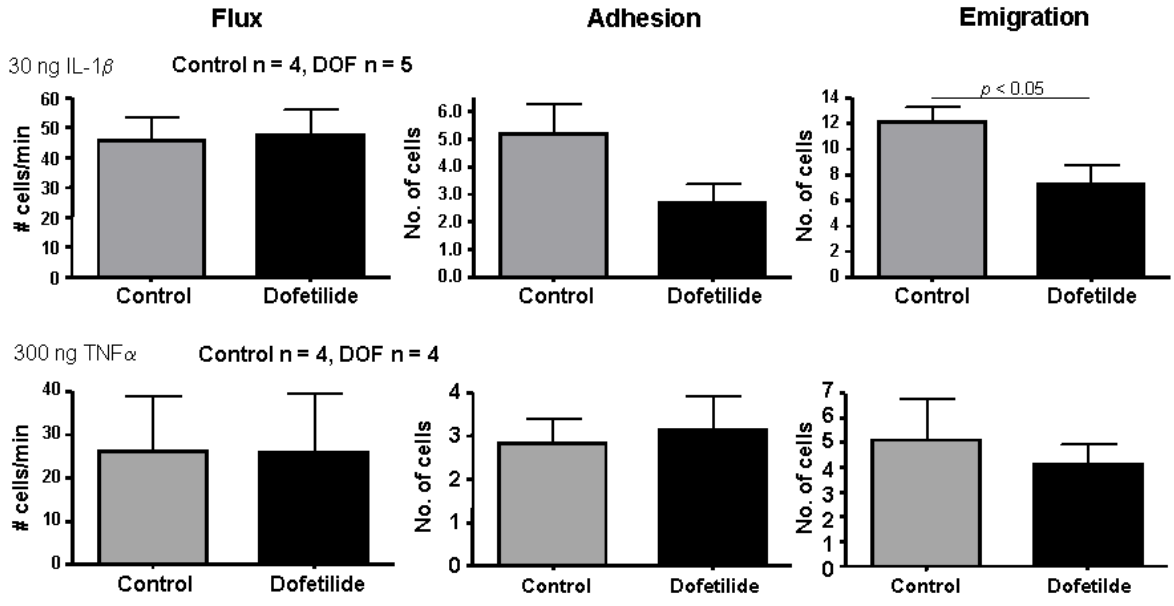
FIGURE 1 . Effect of DOF on leukocyte rolling, adhesion, and emigration through IL-1β–stimulated mouse cremasteric venules. Animals were injected intrascrotally with either IL-1β (30 ng; top row) or TNFα (300 ng; bottom row) 4 h prior to externalization of the cremaster muscle for intravital microscopy in which mice had further been injected i.p. with either saline or DOF (10 mg/kg) 10 min prior to video recording. Data represent the mean ± SEM, where the number (n) of mice are defined within each